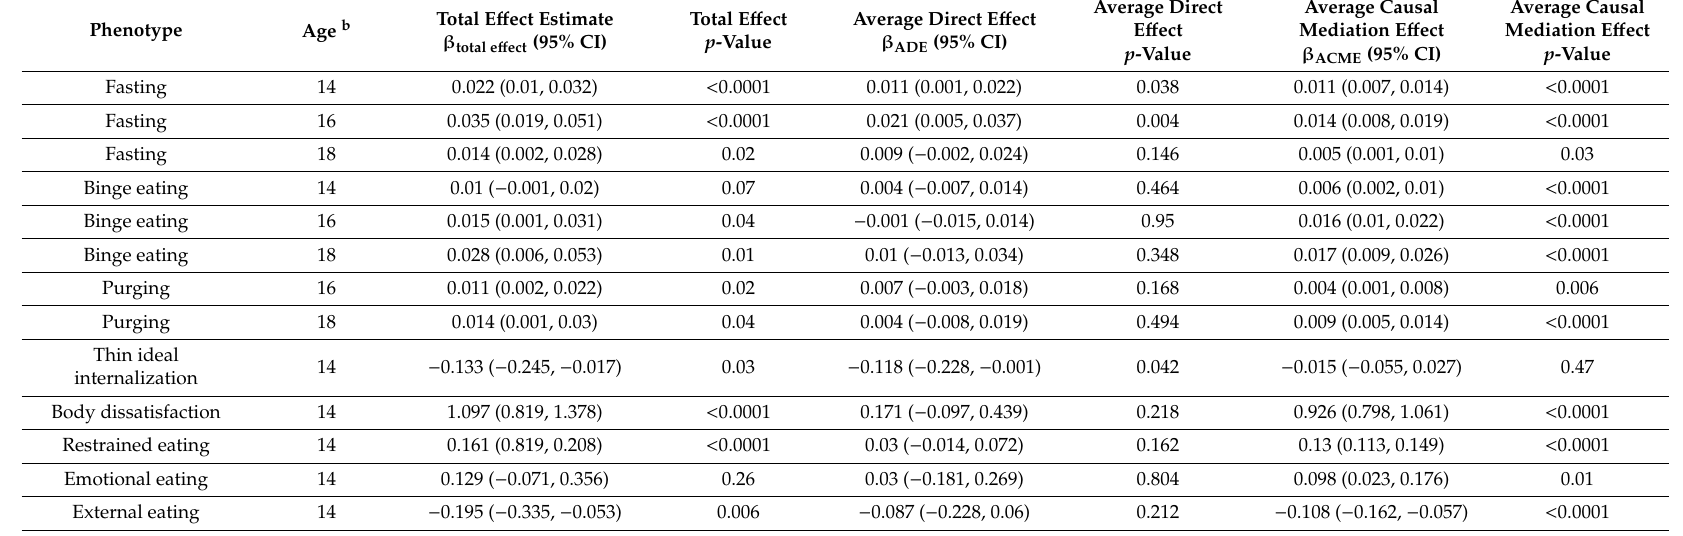
Table 3. Exploratory causal mediation analysis of the association between the disordered eating outcomes and the standardized body mass index polygenic score (BMI-PGS) with the age- and sex-adjusted body mass index z-scores at age 11 years as mediator a . p -values for mediation were generated with bootstrapping